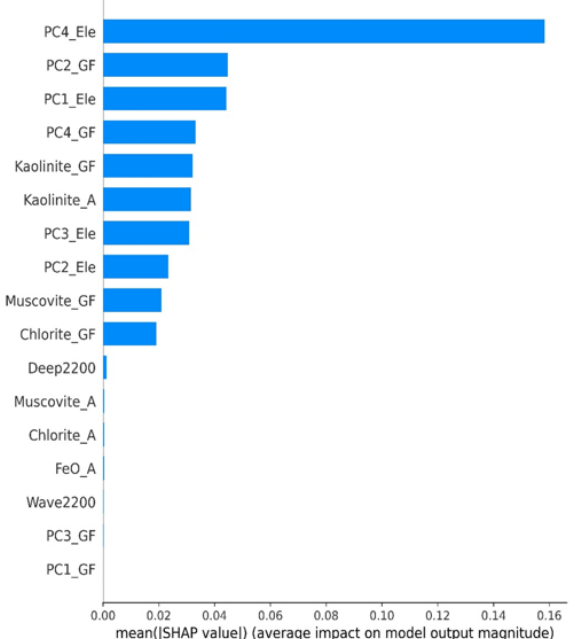
Figure 18. SHAP scores for feature importance by the CNN classification. Greater scores indicate greater significance in distinguishing the areas from ore/ore-free.